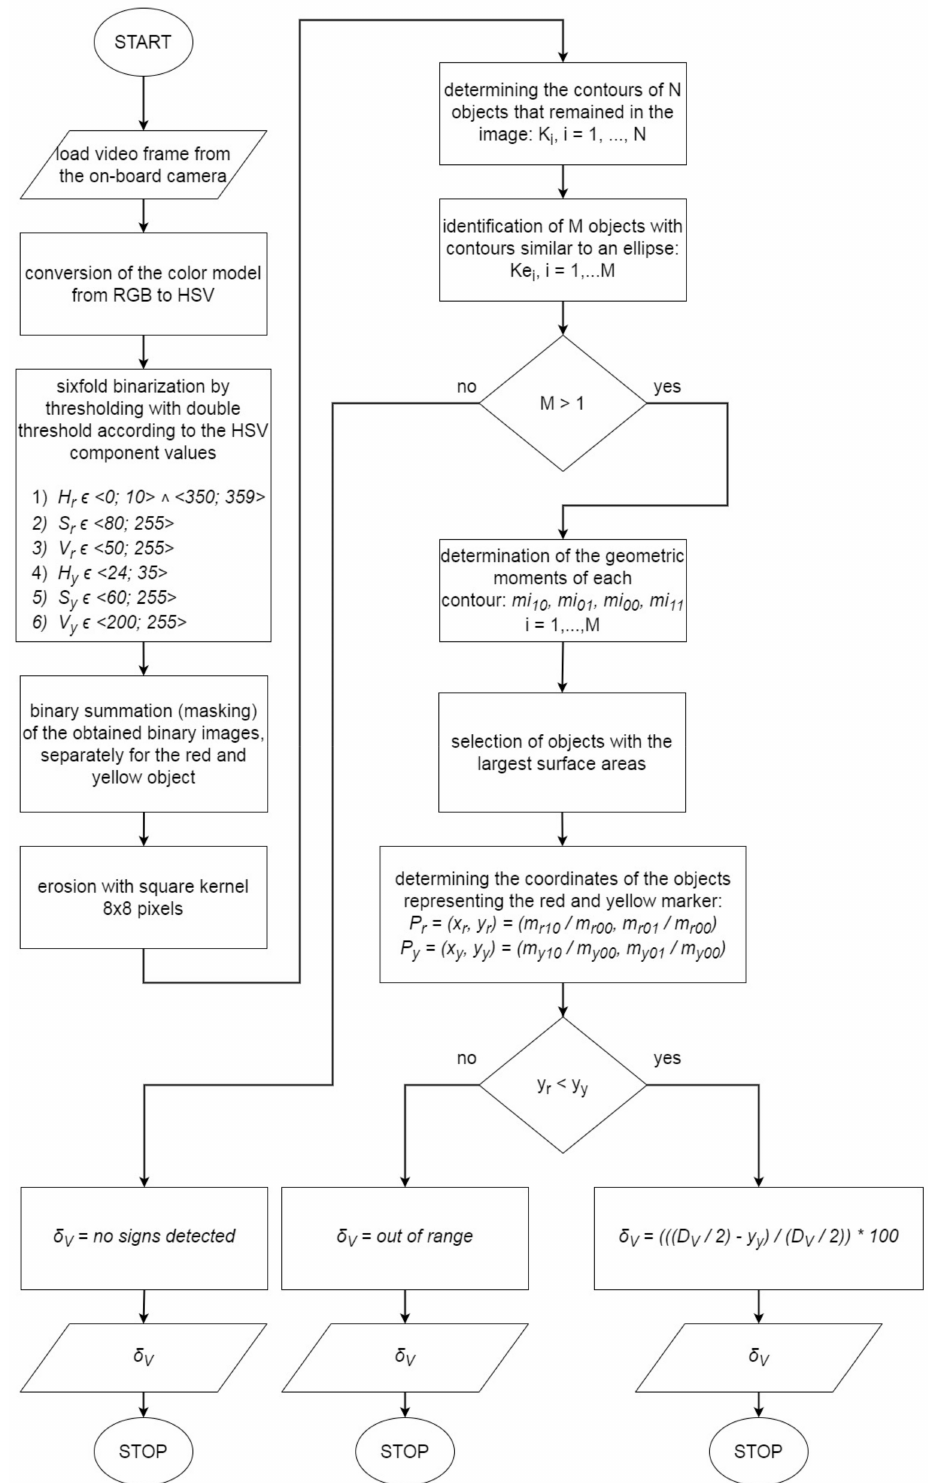
Figure 5. The image processing algorithm for a single frame of the picture determining the position of ground signs. H, S, V—pixel color components for yellow (y) and red (r) circles; M —number of identified elliptical objects; P r (x r , y r ) , P y (x y , y y ) —position of respectively red and yellow circle on the picture in pixels; δ v —vertical deviation of the signs from the aiming point system from the center of the